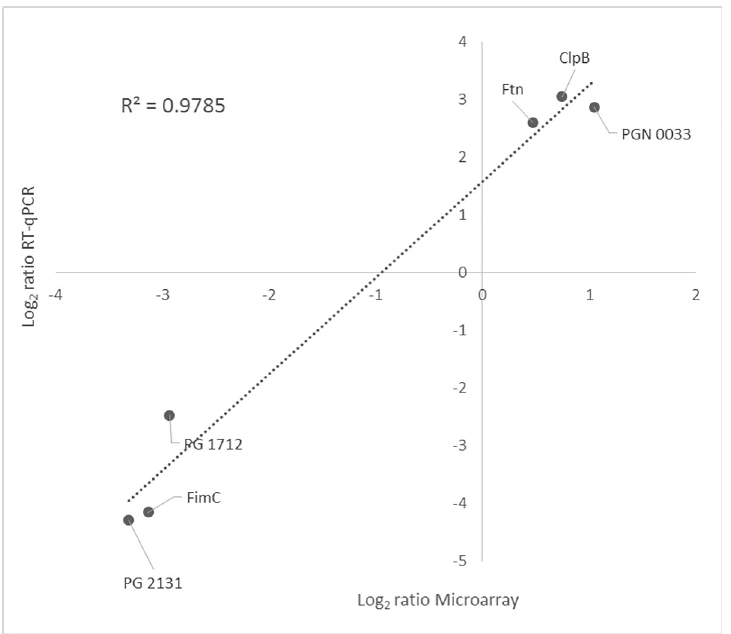
Fig 6. Correlation between Microarray and Reverse Transcription-quantitative Polymerase Chain Reaction (RT- qPCR) gene expression ratios when comparing Porphyromonas gingivalis ATCC 33277 growing within a multispecies-biofilm versus planktonic growth. RT-qPCR log 2 values were plotted against the microarray data log 2 values (R 2 = 0.9785).